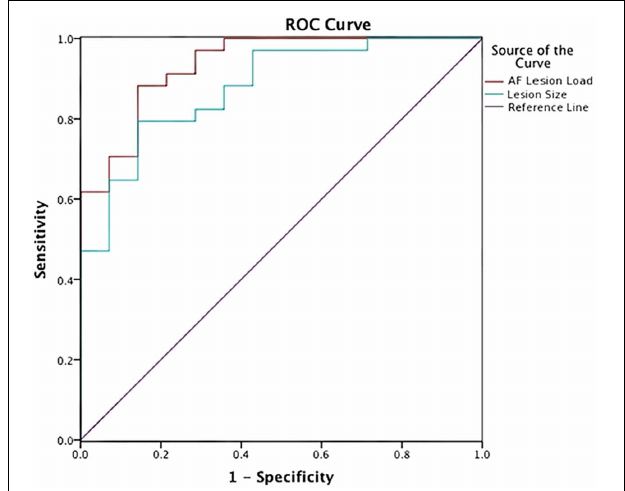
FIGURE 5 | Speech Fluency ROC curve shows prediction from AF-LL and lesion volume for speech fluency. AF lesion load (in red) was the best at 96% in accuracy predicting severe and moderately/mildly affected groups at threshold at 3.75 cc.